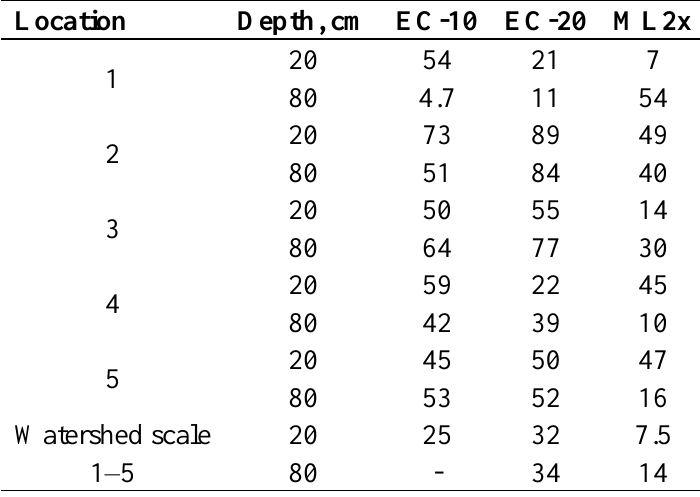
Table 6. Percent improvement in the accuracy of the EC-10, EC-20, and ML2x sensors based on the root mean square error (RMSE) values of the laboratory and default calibration equations to predict the actual soil water content.